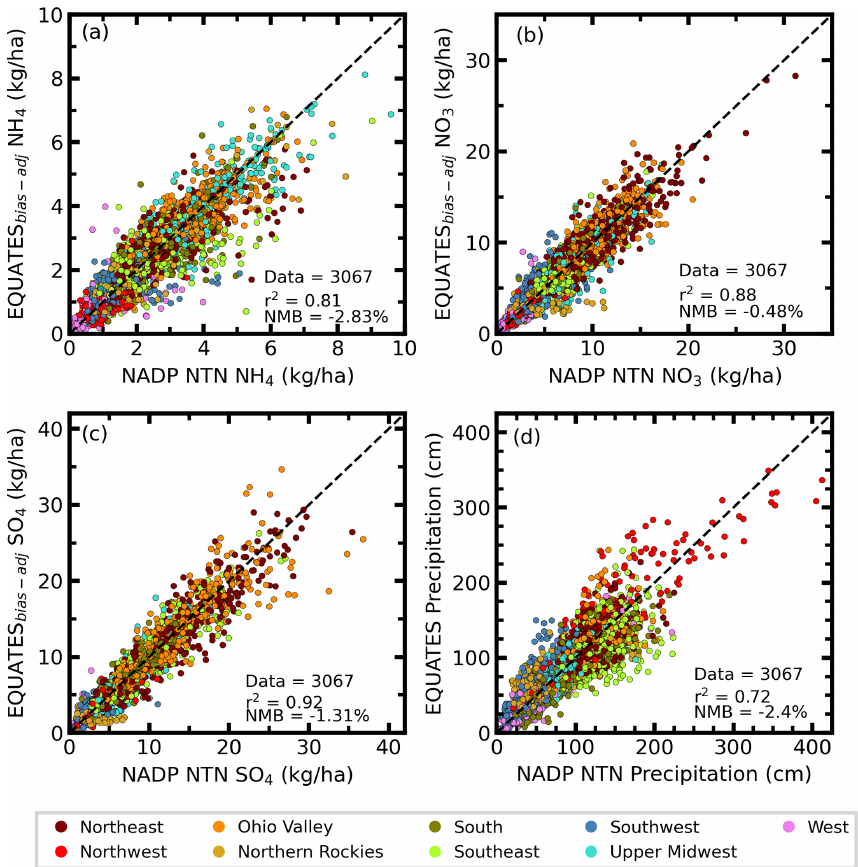
Figure 3. Scatterplots of annual accumulated bias-adjusted modeled and NTN observed wet deposition (kgha − 1 ) of ammonium ( a , NH 4 ), nitrate ( b , NO 3 ), and sulfate ( c , SO 4 ) from 2002 to 2017 colored by the climate region. Panel (d) shows NADP NTN observed and modeled precipitation